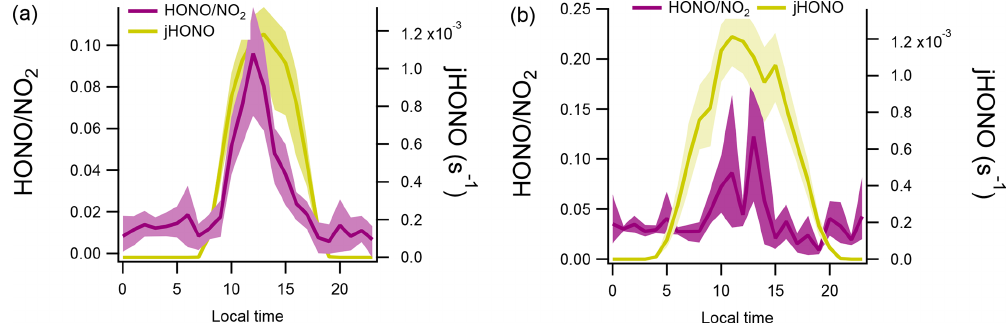
Figure 4. Diurnal profiles of HONO / NO 2 ratios and HONO photolysis rates at CVAO (a) and WAO marine (b) . Shaded areas represent the 95% confidence intervals of the measurement